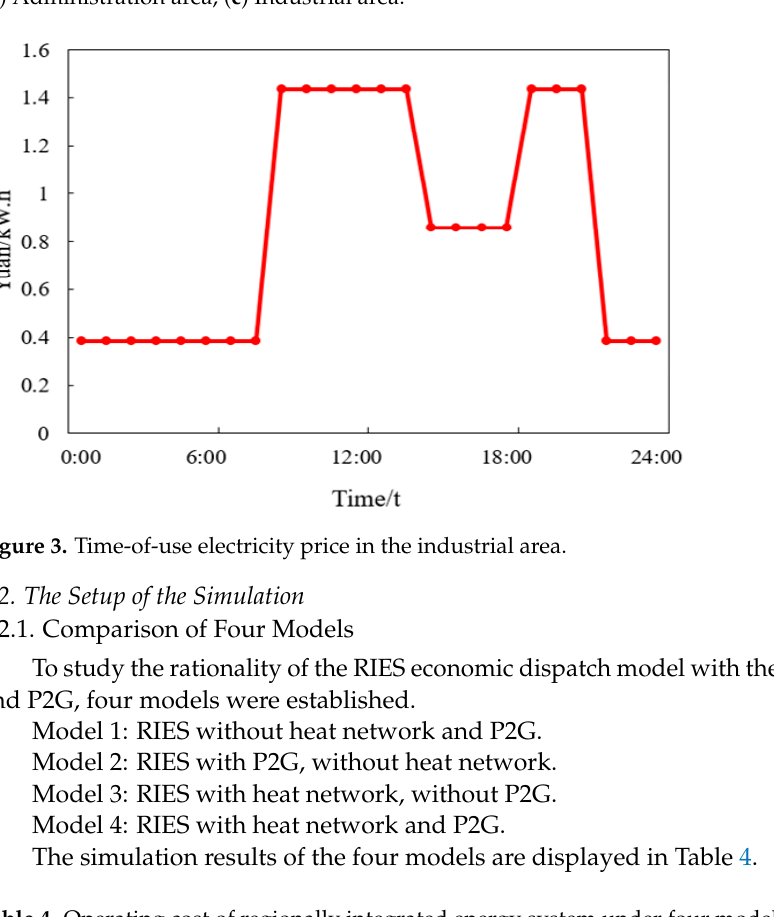
Table 4. Operating cost of regionally integrated energy system under four models.